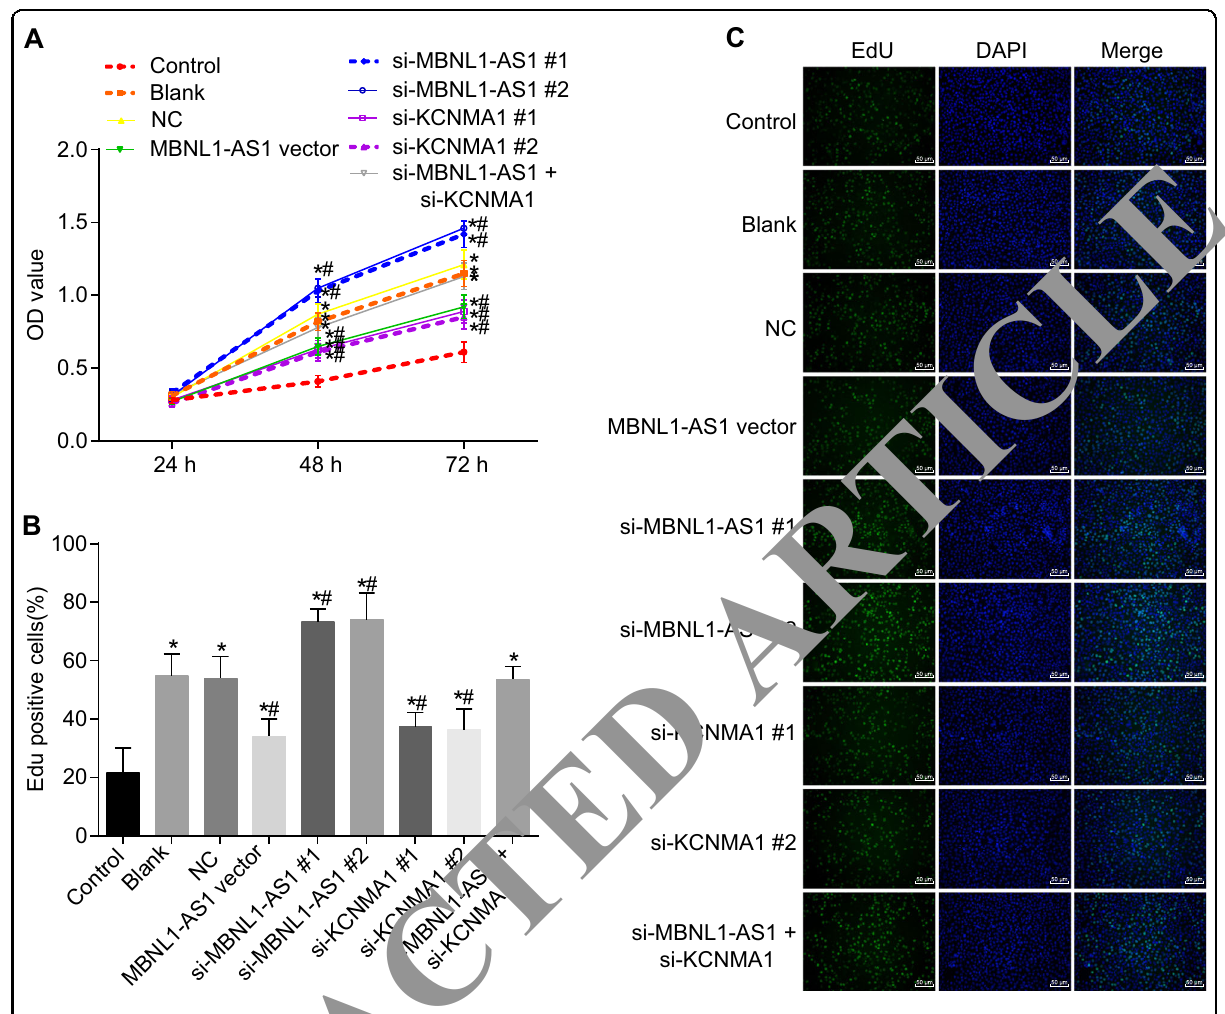
Fig. 8 MTT and EdU assays showed that MBNL1-AS1 inhibited the proliferation of skeletal muscle cells. a Cell proliferation in each group as measured by MTT. b Cell proliferation in each group as measured by EdU. c Cell proliferation in each group as measured by EdU (×50). OD optical density, MBNL1-AS1 muscleblind-like 1 antisense RNA 1, KCNMA1 potassium calcium-activated channel subfamily M alpha 1, si small interfering, NC negative control; * p < 0.05 vs. the control group; # p < 0.05 vs. the blank and NC groups; scale bar = 200 µm; the experiment was repeated 3